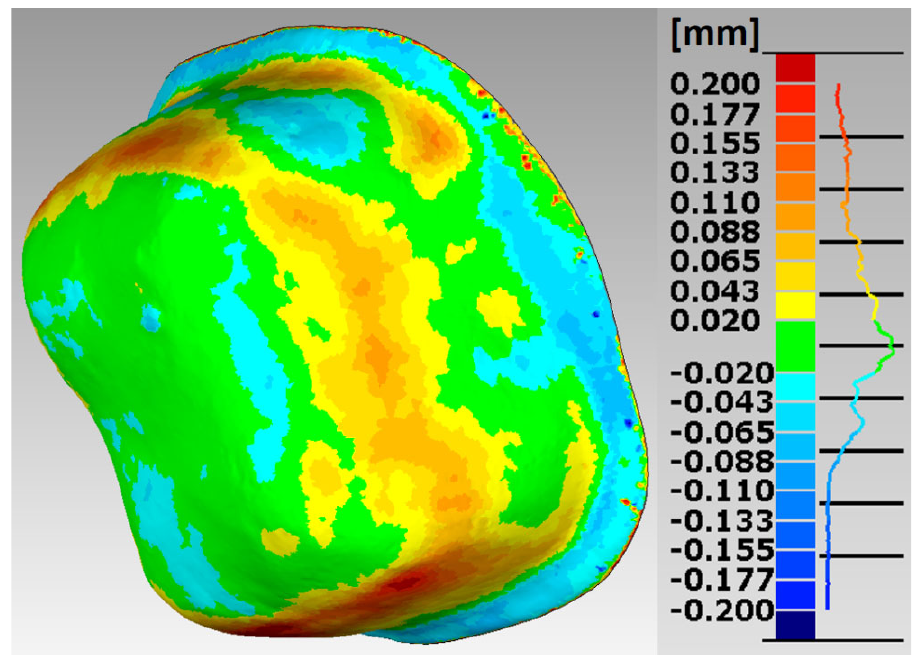
Figure 10. Map of errors in mapping the shape of a crown made of Ti6Al4V alloy in the milling for molar tooth 36.